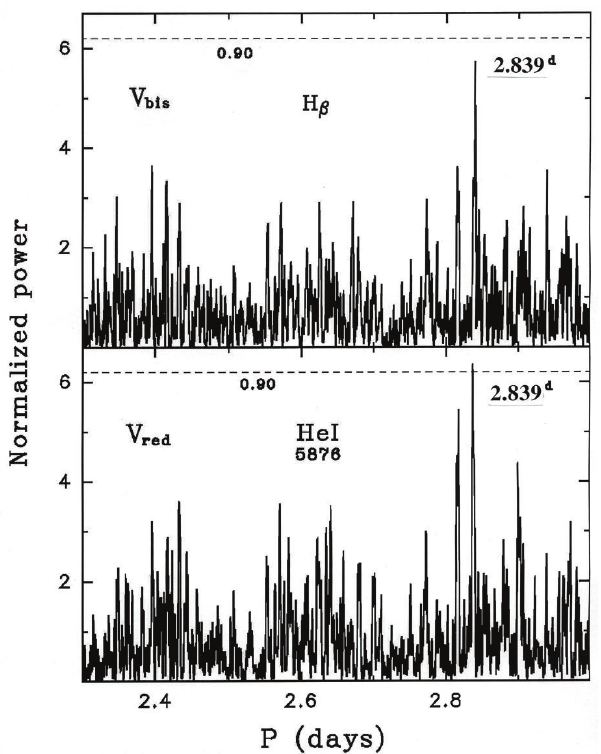
Figure 6. Lomb-Scargle periodogram for the parameters V bis (H β ) and V red (He I λ 5876) from the HD259431 spectra. The same period, P = 2.839d, is visible in both periodograms.